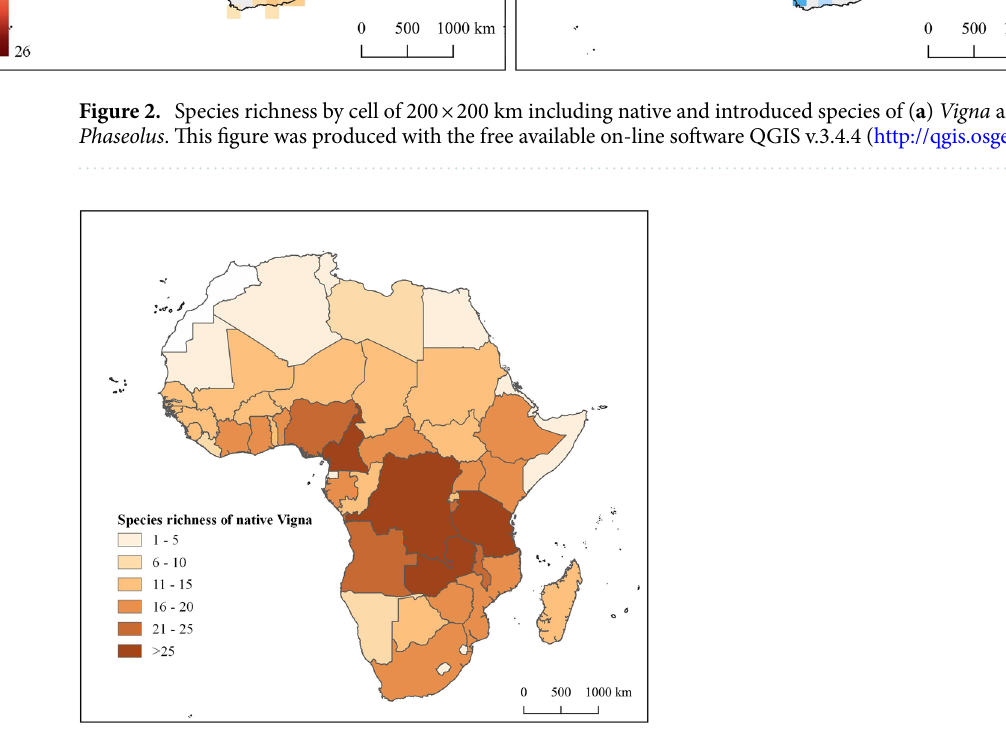
Figure 3. Species richness of native Vigna by country. This figure was produced with the free available on-line software QGIS v.3.4.4 (http:// qgis. osgeo.